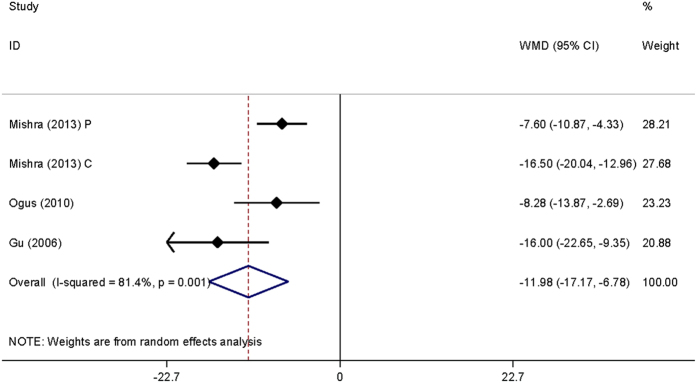
Forest plot of serum ACE activity for the comparison of ACE gene II genotype with DD genotype.